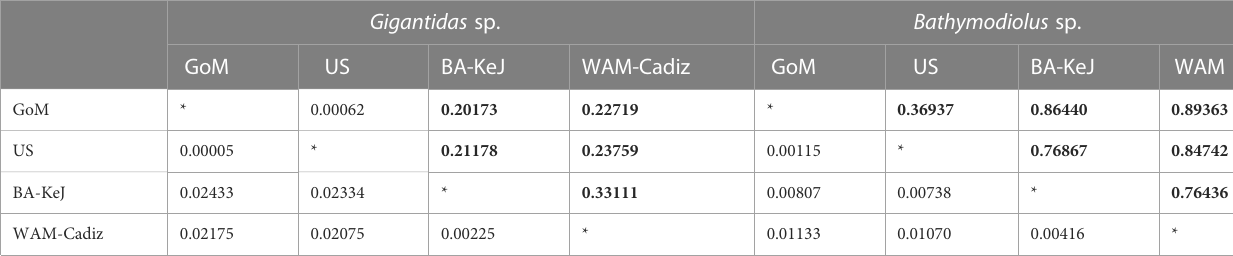
TABLE 5 Net genetic distance (Da, below the diagonal) and Fst values (above the diagonal) for Gigantidas sp. and Bathymodiolus sp . calculated between the four populations de fi ned based on haplotype networks and ASAP analyses (see Table 1 for details).